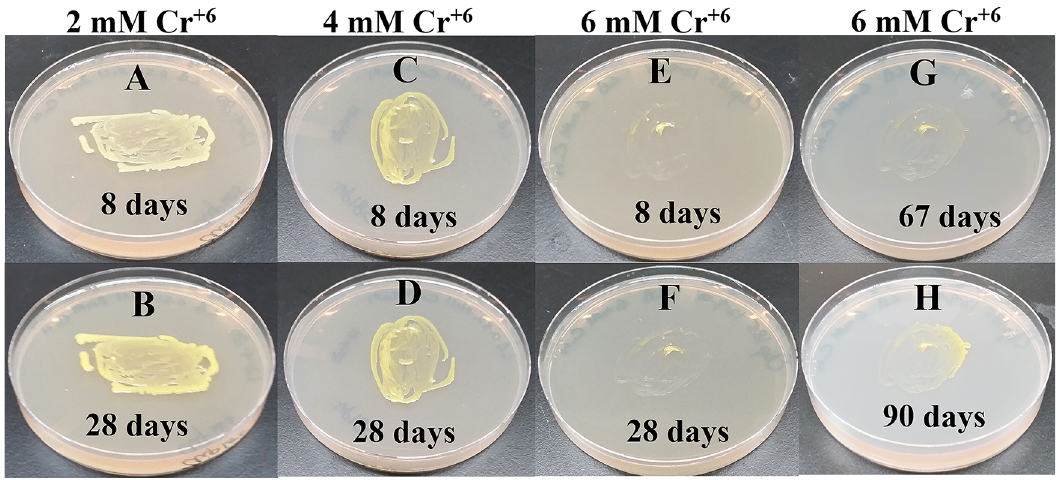
Figure 19. Growth of Clip185 on LB media containing hexavalent Chromium (Cr 6+ ). (A) 8 days-growth of Clip185 on LB media containing 2 mM Cr 6+ . (B) 28 days-growth of Clip185 on LB media containing 2 mM Cr 6+ . (C) 8 days- growth of Clip185 on LB media containing 4 mM Cr 6+ . (D) 28 days-growth of Clip185 on LB media containing 4 mM Cr 6+ . (E) 8 days-growth of Clip185 on LB media containing 6 mM Cr 6+ . (F) 28 days-growth of Clip185 on LB media containing6mMCr 6+ .(G)67days-growthofClip185onLBmediacontaining6mMCr 6+ .(H)90days-growthofClip185 on LB media containing 6 mM Cr 6+ . Number of days of growth are labeled on the figures. Light intensity was 10-15 μ mol m -2 s -1 . See also Underlying data.